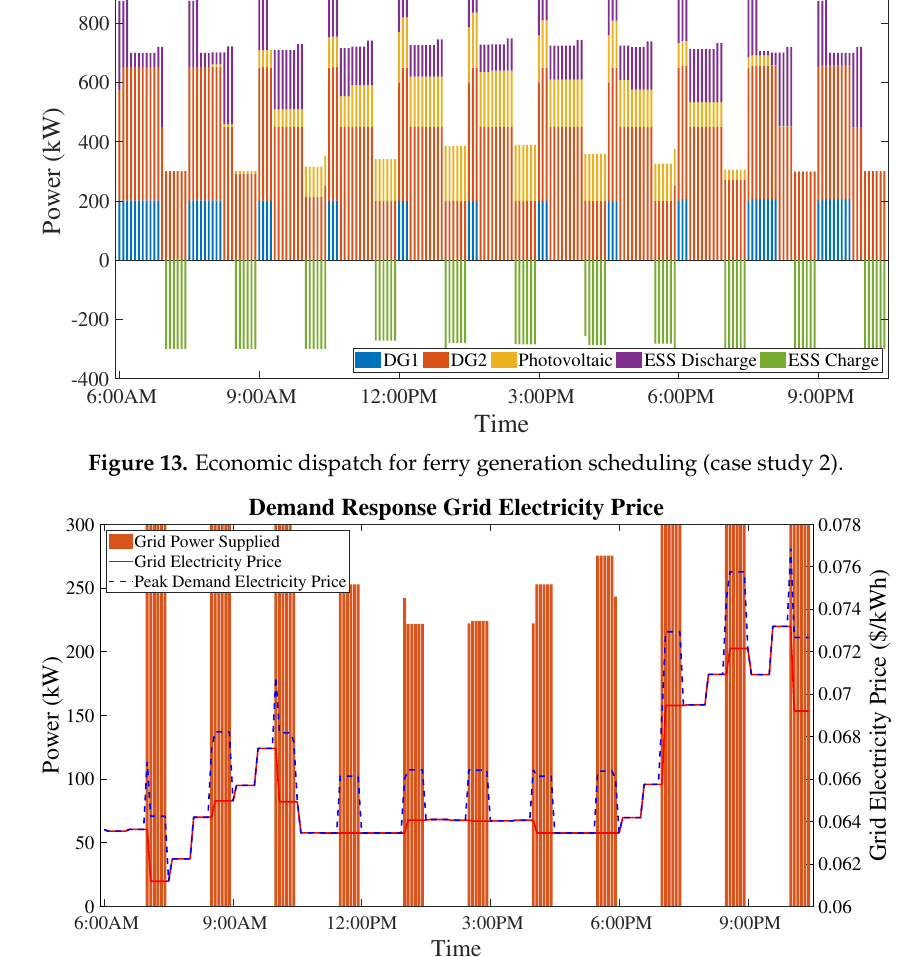
Figure 14. S2S power demand and peak demand response electricity price (case study